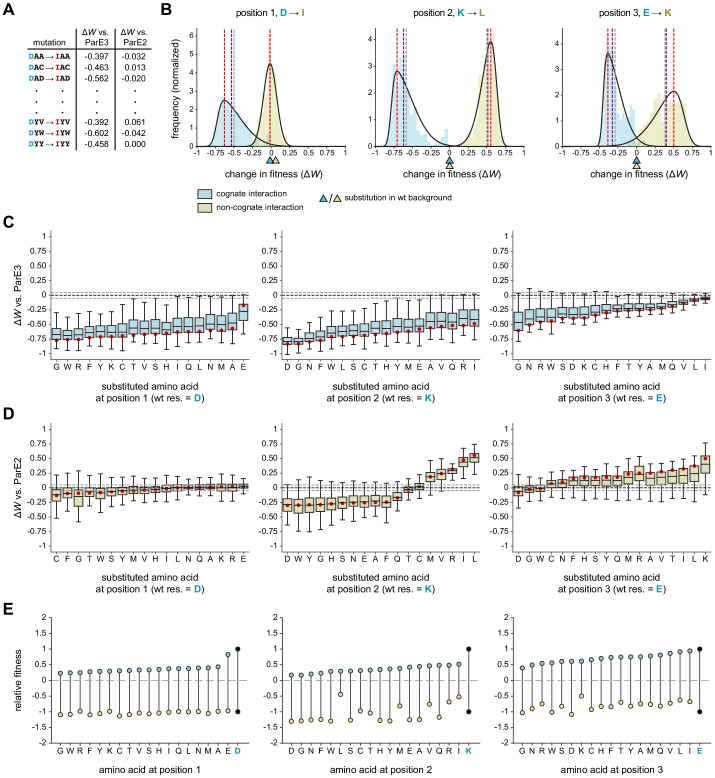
Systematic dissection of interface substitutions.(A) Example illustrating how each substitution occurs in hundreds of contexts in the saturation mutagenesis library. (B) Distribution of fitness effects for the substitutions indicated (each replacing a specificity residue in ParD3 with the corresponding residue in ParD2) in all possible contexts, fitted to skew normal distributions. The effect on the cognate interaction is shown in blue, and the effect on the non-cognate interaction is shown in gold. Mean (gray), median (purple), and mode (red) are indicated. Triangles denote the effect of each substitution in the wild-type background (DKE). (C–D) Box plots showing the distribution of fitness effects for each substitution. For each substitution, the effects on fitness against ParE3 (C, blue) and ParE2 (D, gold) are shown. The mode of the fitted skew normal distribution is indicated in red. Dashed lines represent the threshold for a mode not expected by chance (<5% FDR based on 1000 permutation tests). Outliers (1.5 * IQR) are hidden for clarity but were included in all quantitative analyses. (E) Diagram illustrating how each substitution affects fitness for both ParE3 and ParE2. Starting fitness of the wild-type antitoxin is arbitrarily set to W = 1 for ParE3 and W = −1 for ParE2 (black dots). Blue and gold points represent shifts in fitness for variants when tested against ParE3 and ParE2, respectively, based on the mode effect size measured in (C) and (D).